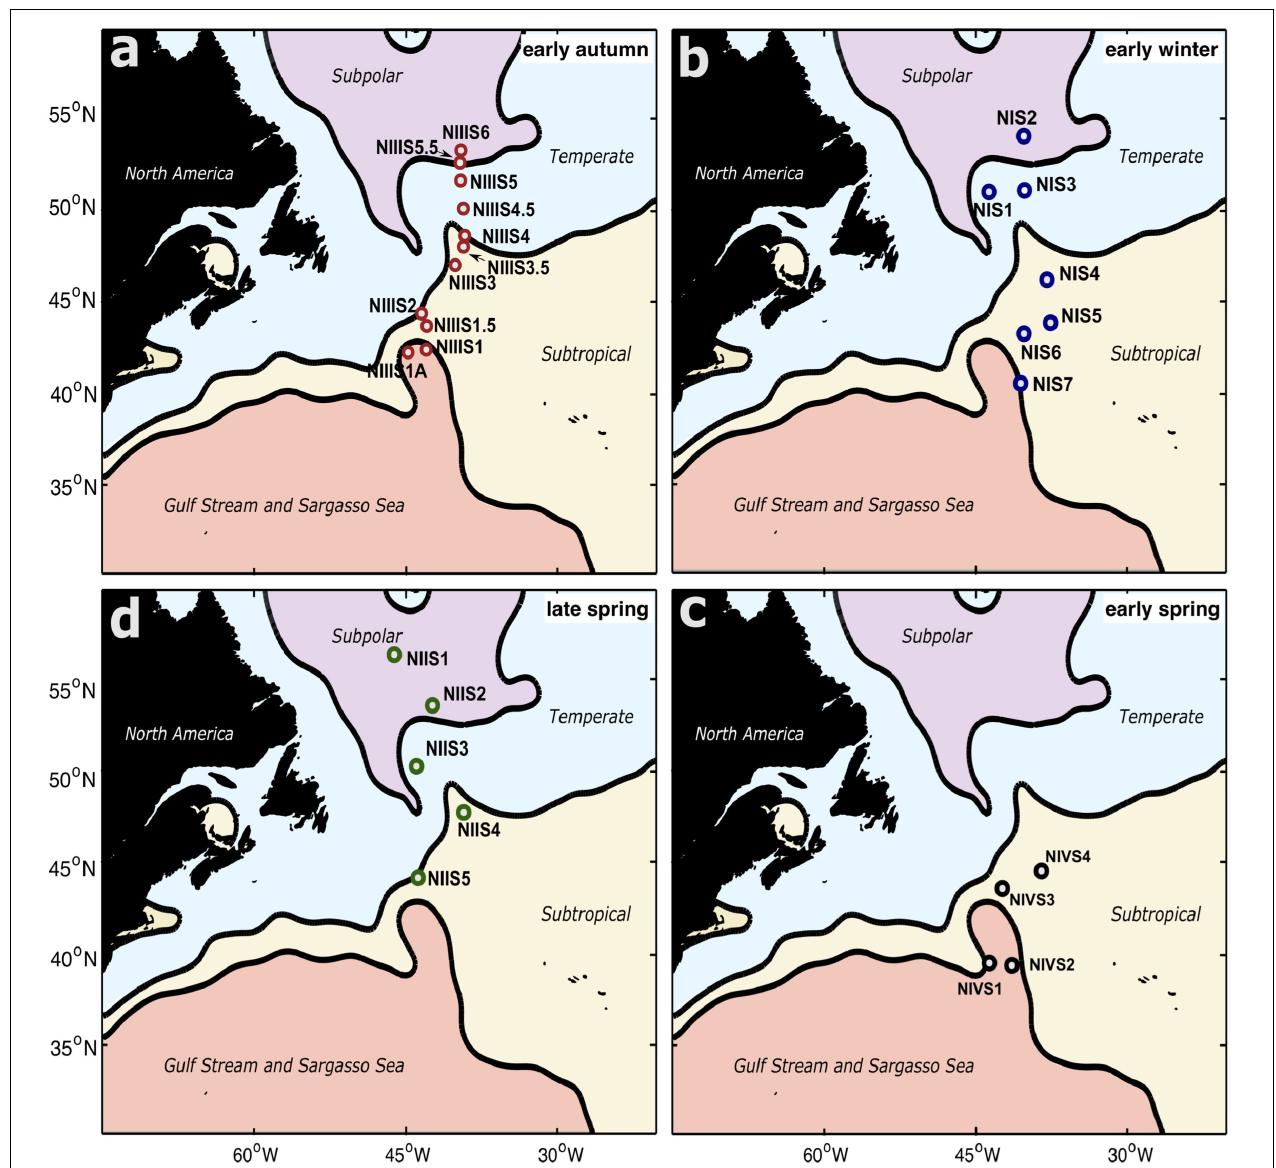
FIGURE 1 | Map of the sampled stations in the western North Atlantic overlapped with the subregions established by Mean Dynamic Topography analysis. Panels in clockwise direction: (a) early autumn (NAAMES field campaign NIII: September 2017) (b) early winter (NAAMES field campaign NI: November 2015) (c) early spring (NAAMES field campaign NIV: April-March 2018) (d) late spring (NAAMES field campaign NII: May